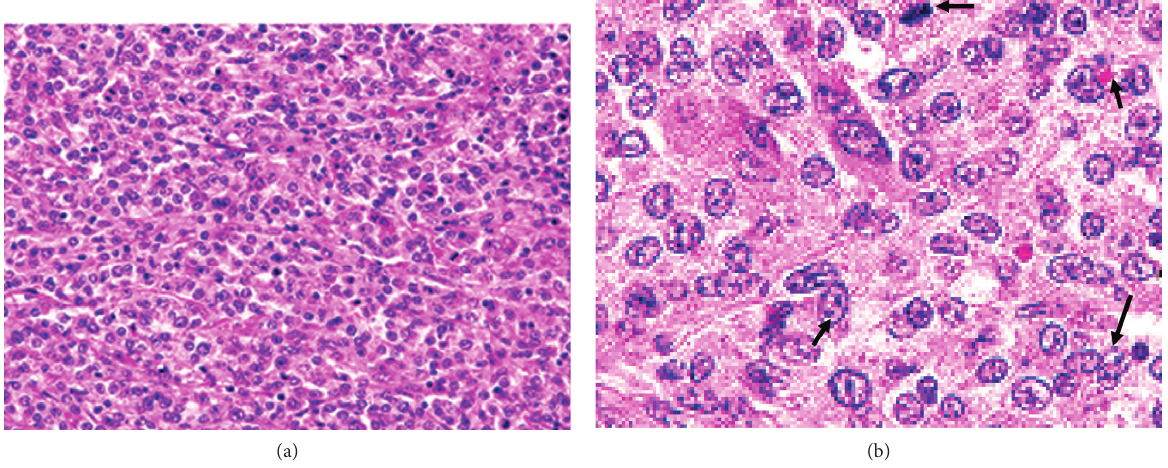
Figure 2: Histopathology of hepatocellular carcinomas of a bull.